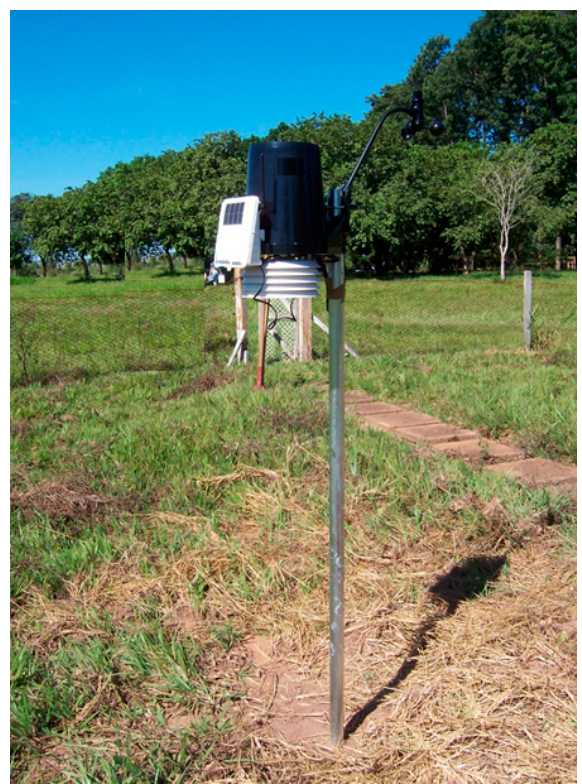
Figure 7. Davis Instruments Vantage Pro 2 weather station.